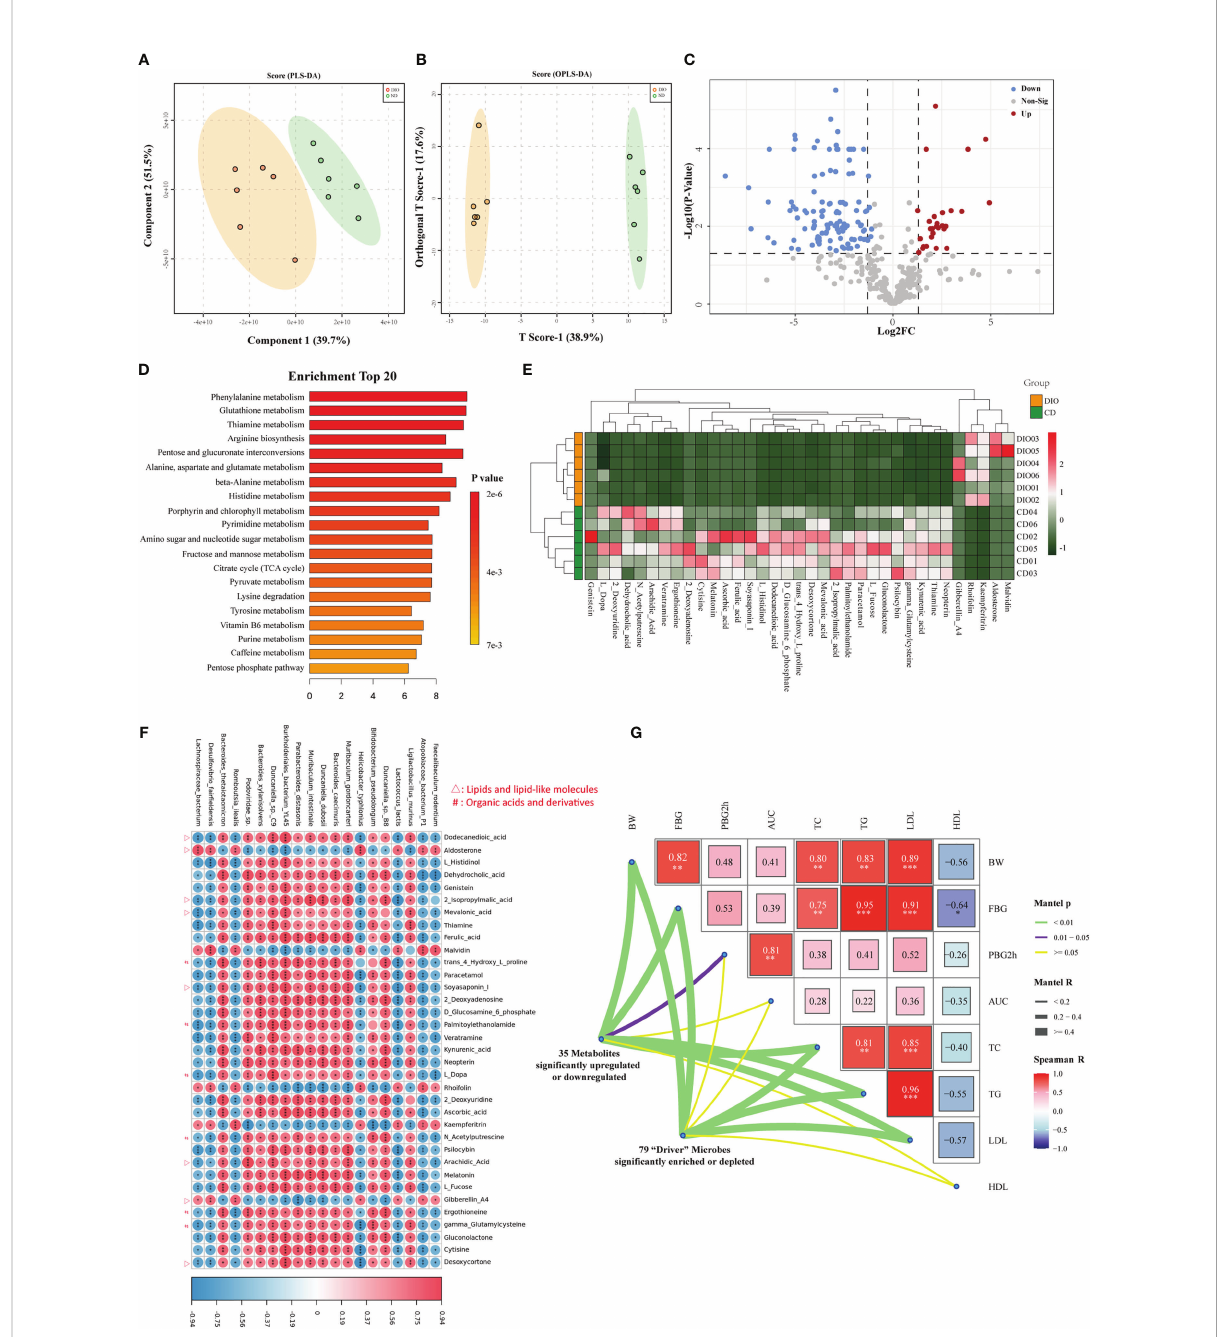
FIGURE 6 Metabolomics analysis revealed aberrant metabolic patterns in MHO mice. Both PLS-DA (A) and OPLS-DA (B) showed a signi fi cantly-different distribution of metabolites in MHO and controls. (C) Volcano plot. The log2 fold-change indicates the mean relative abundance for each metabolite. Each dot represents one metabolite. The gray dots represent no signi fi cant expression difference between the MHO and control groups, the red dots represent MHO-enriched metabolites, and the blue dots represent MHO-depleted metabolites. (D) Enrichment analysis of differentially expressed metabolites shows the top 20 enriched pathways in MHO metabolism. (E) Heatmap visualization of the thirty- fi ve metabolites with | LogFC|>4 in the MHO groups compared with the controls. (F) A correlation heatmap linking the top 20 signi fi cantly-differentiated bacteria with the above 35 signi fi cantly-changed metabolites. (G) The triangle on the right side represents pairwise comparisons of clinically relevant factors with a color gradient denoting Spearman correlation coef fi cients. The 79 signi fi cantly enriched or depleted microbes and 35 signi fi cantly changed metabolites were related to each clinical factor, respectively, using partial (geographic distance – corrected) Mantel tests. Edge width corresponds to the Mantel r statistic for the corresponding distance correlations, and edge color denotes the statistical p signi fi cance value. PLS-DA: The Partial least squares discriminant analysis; OPLS-DA: Orthogonal Partial least squares discriminant analysis. * p 0.05 ** p 0.01 *** p